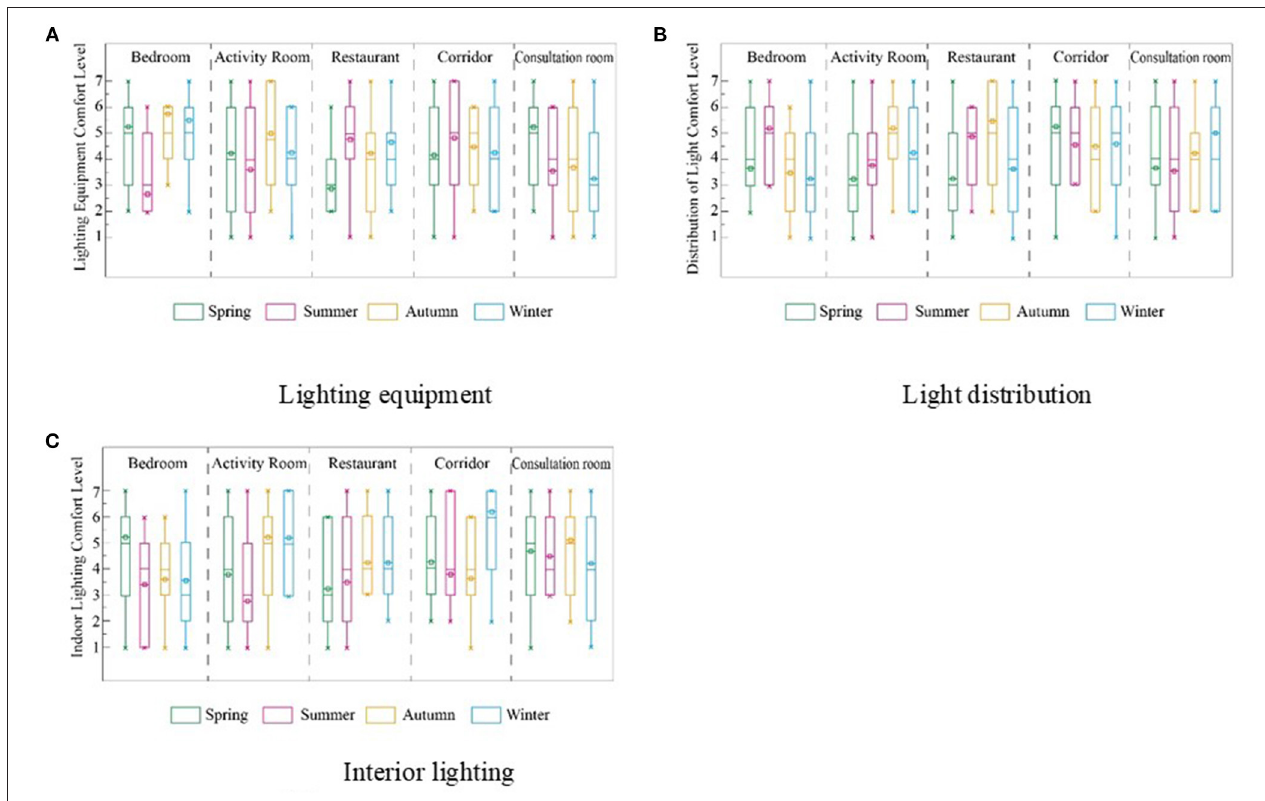
FIGURE 6 | Evaluation of lighting factors of 4 RECFs based on seasonal differences. (A) Lighting equipment, (B) Light distribution, and (C) Interior lighting.